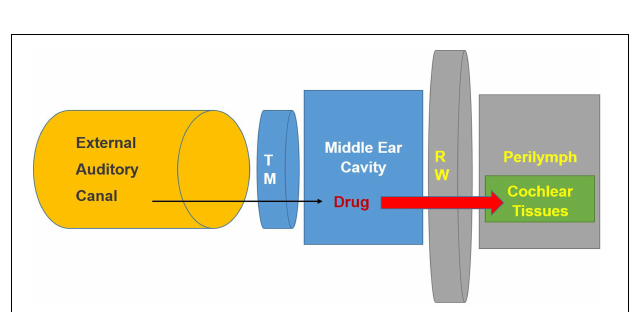
FIGURE 2 | Schematic diagram illustrating method for intra-tympanic injection. The drug is injected through the tympanic membrane (Heinrich et al., 2016) into the middle ear. It then can penetrate the round window membrane (RW) to enter the inner ear fluids (perilymph) and tissues. Modified from the ACS article https://pubs.acs.org/doi/abs/10.1021%2Facs.jmedchem. 7b01653 with